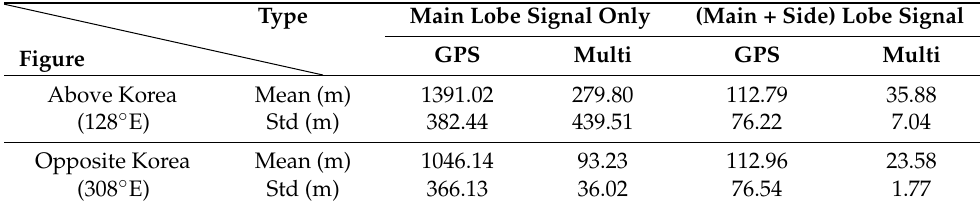
Table 6. Navigation error for 24 h in geostationary orbit.